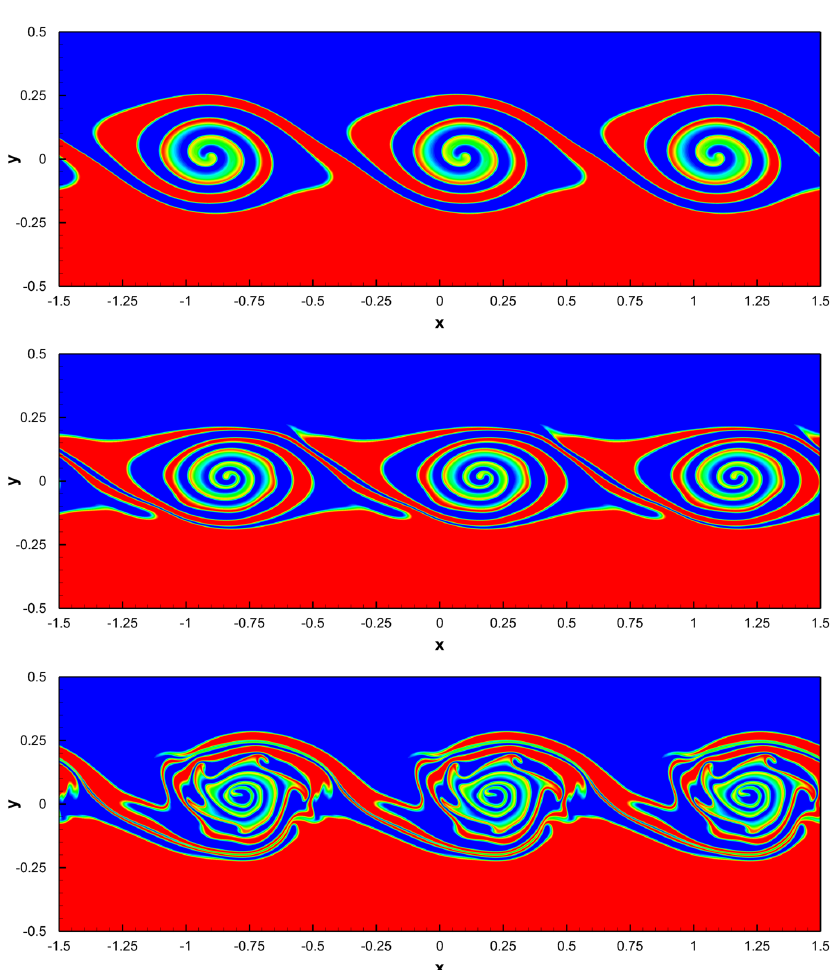
Figure 20. Temporal evolution of the density contours of the 2D compressible Kelvin–Helmholtz instability at times t = 4, t = 5, t = 6, t = 7, t = 8, from top to bottom . Three periods of the periodic domain in the x direction are −